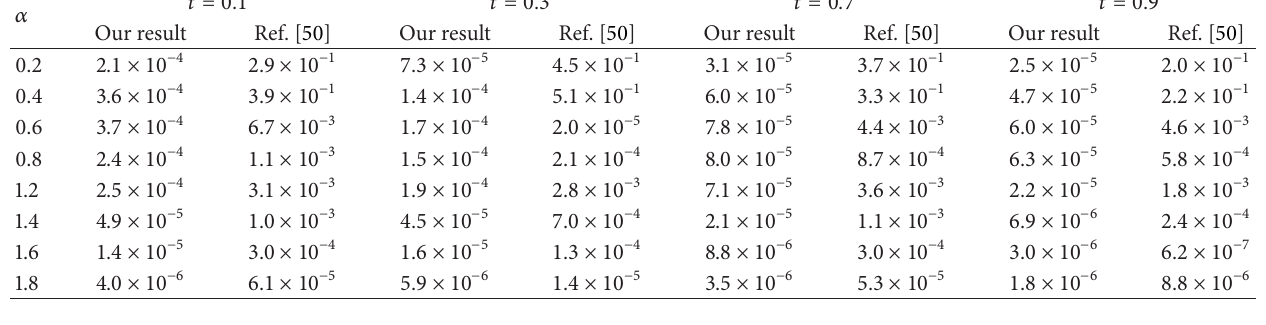
Table 6: Comparison of absolute errors in 𝑦(𝑡) in [50] and the ones obtained by our method for Example 7. 𝛼